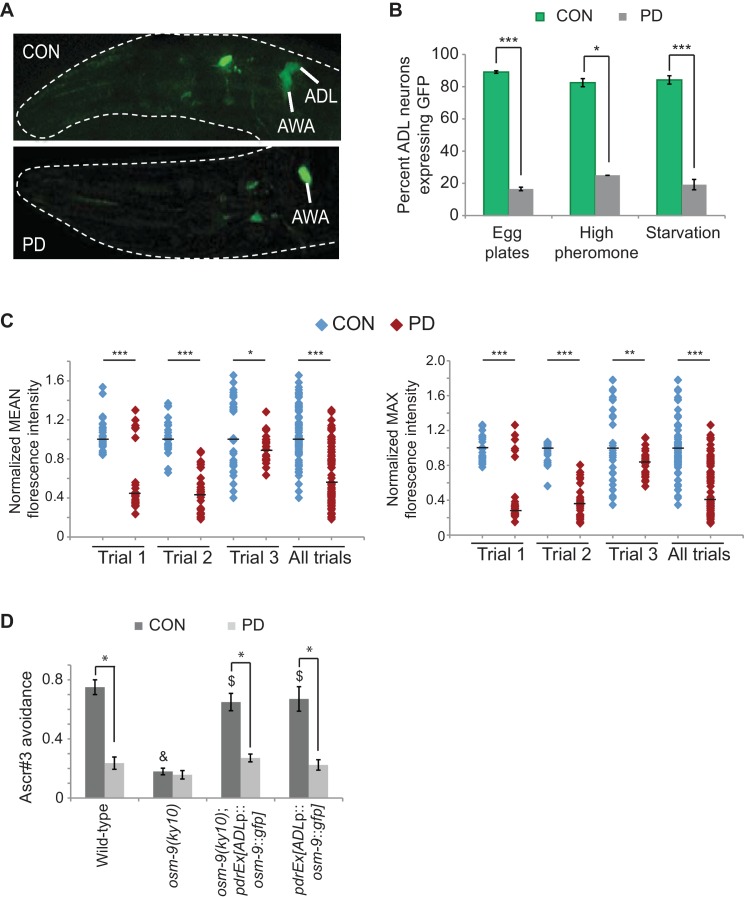
The osm-9 TRPV channel gene is regulated by developmental history.(A) An osm-9p::gfp transgene is expressed in ADL and AWA neurons in CON adults, but is down-regulated in ADL neurons in PD adults. (B) osm-9p::gfp expression in ADL neurons in CON and PD adults that entered dauer due to crowding (egg plates), exposure to crude pheromone with low population density, or starvation. N ≥ 2 trials; n ≥ 40 animals (Figure 1—source data 1). **p<0.005, ***p<1 x 10–9, Student’s t-test. GFP in AWA is unaffected (Figure 1—figure supplement 1). (C) Quantification of osm-9 mRNA in ADL neurons of CON and PD using smFISH. The graphs represent individual mean and maximum fluorescence measurements for N = 3 biologically independent trials; n ≥ 87 neurons (Figure 1—source data 2). Medians are indicated. ***p<1 x 10–9, **p = 0.006 *p = 0.056, Student’s t-test. See Figure 1—figure supplement 2 and Figure 1—figure supplement 3. (D) Ascr#3 avoidance behavior of CON and PD adults normalized to M13 buffer. N ≥ 3 trials; n ≥ 60 animals (Figure 1—source data 3). Data for ADL-expressed osm-9 rescue strains are averages of two extrachromosomal lines. * indicates CON significantly different from PD; & CON or PD significantly different from wild-type; $ CON or PD significantly different from osm-9(ky10); One-way ANOVA with LSD posthoc correction, p<0.05. All error bars represent S.E.M. OSM-9 mediated behaviors modulated by ASH and AWA neurons are unaffected (Figure 1—figure supplement 1 and Figure 3—figure supplement 2).DOI:
http://dx.doi.org/10.7554/eLife.11642.00310.7554/eLife.11642.004Figure 1—source data 1.Spreadsheet of percentages of animals expressing osm-9p::gfp in ADL neurons of wild-type strains that experienced overcrowding, high pheromone, or starvation conditions.DOI:
http://dx.doi.org/10.7554/eLife.11642.00410.7554/eLife.11642.005Figure 1—source data 2.Spreadsheet containing mean and maximum florescence intensities of osm-9 smFISH probes in wild-type ADL neurons.DOI:
http://dx.doi.org/10.7554/eLife.11642.00510.7554/eLife.11642.006Figure 1—source data 3.Spreadsheet containing ascr#3 avoidance values for CON and PD in wild-type, osm-9(ky10), and ADL-specific, osm-9 rescue strains.